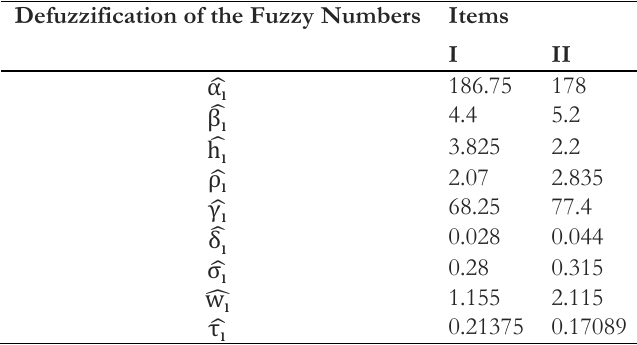
Table 2. Defuzzification of the fuzzy